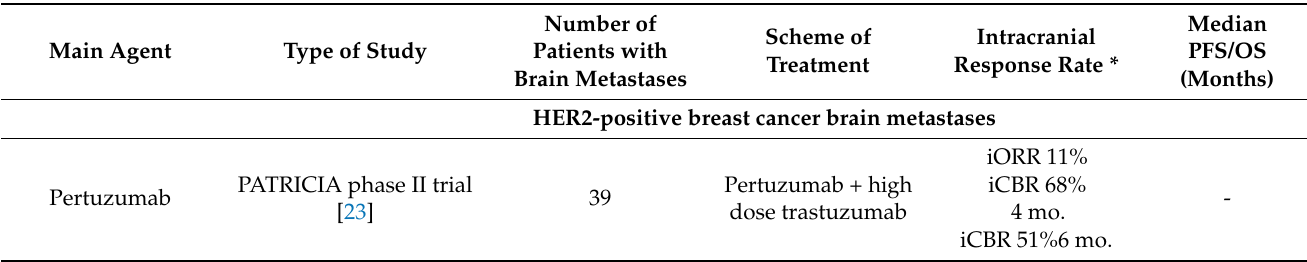
Table 1. Intracranial response rate based on the results of available clinical trials including patients with breast cancer and brain